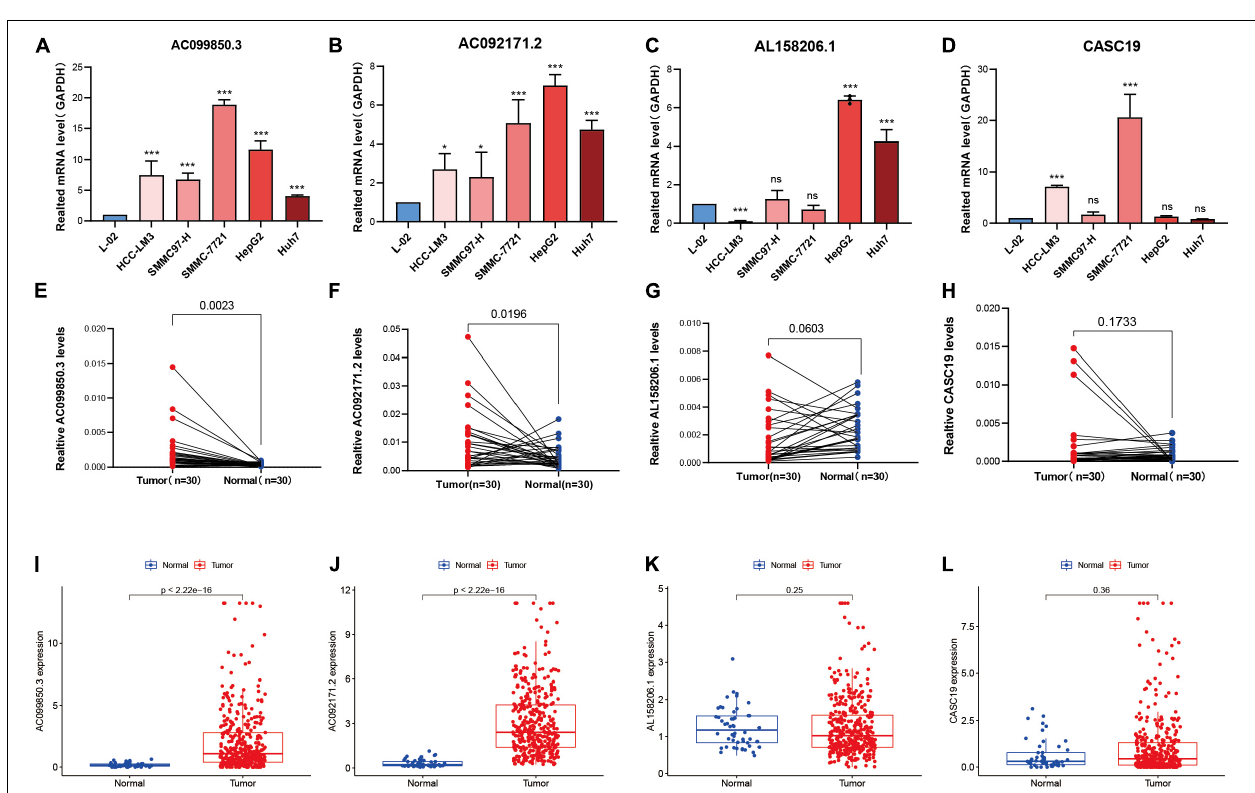
FIGURE 4 | Kaplan–Meier survival analysis in different clinicopathological characteristic subgroups. (A) Age ≤ 60; (B) Age > 60; (C) Male; (D) Female; (E) Grade 1–2; (F) Grade 3–4; (G) Clinical stage I–II; (H) Clinical stage III–IV.